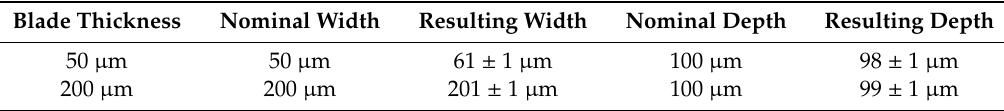
Figure 5. Optical microscope images of microfluidic channels realized with di ff erent blade thicknesses. ( a , b ) show the channels realized with 200 and 50 µ m-thick blades, respectively. ( c , d ) report examples of the output waveguides captured by the near-field technique, referring respectively to channels obtained by with 200 and 50 µ m-thick blades. Both structures do not evidence any di ff erences between the two crystallographic directions. Table 1. Results of the profile analysis carried out on 10 di ff erent channels, in di ff erent positions inside them. More than 10 profiles are considered for each channel, using the profilometer P-10 (KLA Tencor, CA, USA). The table reports the di ff erence between the average values and the nominal ones.